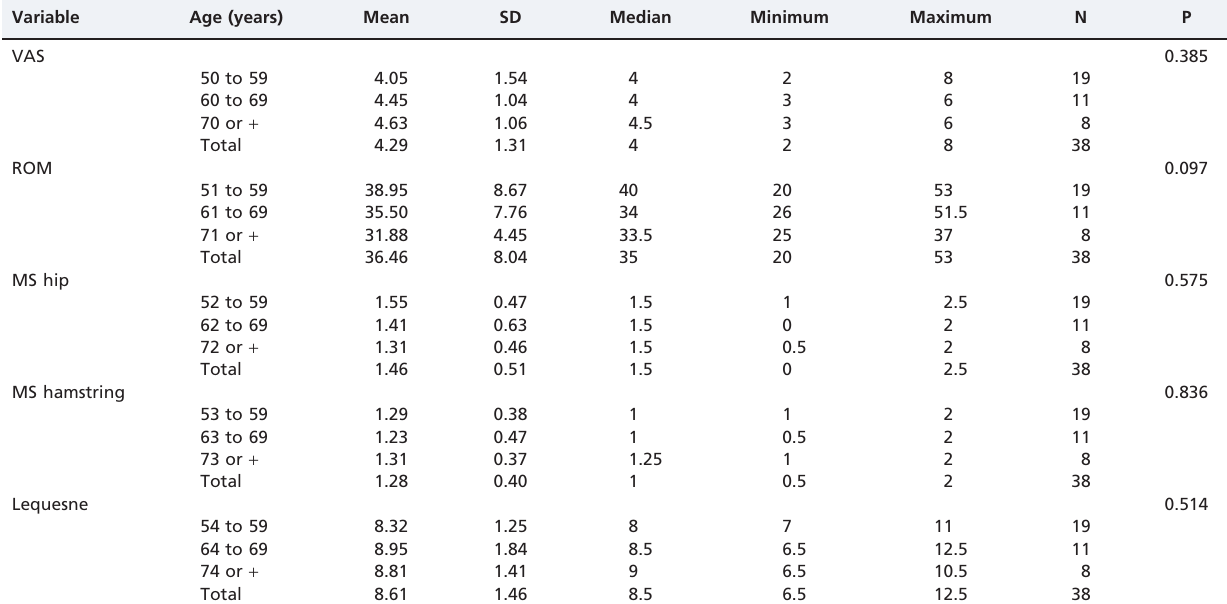
Table 3 - Changes in the measurements of pain (analyzed by the visual analogue scale, VAS), range of joint movement (ROM), muscle strength (MS) and functional status (by the Lequesne Algofunctional Questionnaire for Osteoarthritis of the Knees) according to age and results of the comparisons between the age